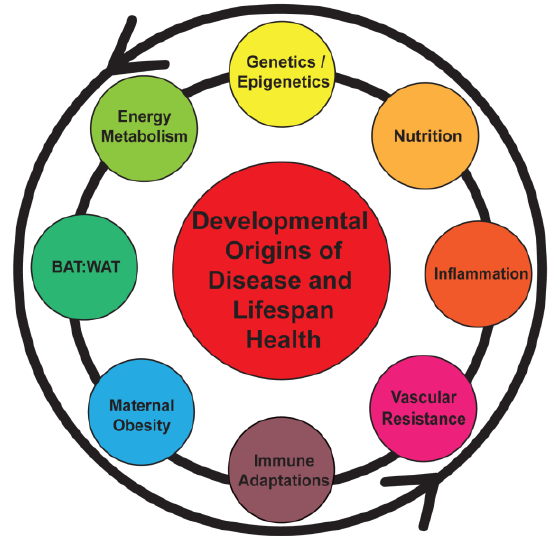
Figure 1. Early programming can be initiated by a number of maternal and fetal factors that sets the stage for a lifetime of health or disease. BAT, brown adipose tissue; WAT, white adipose